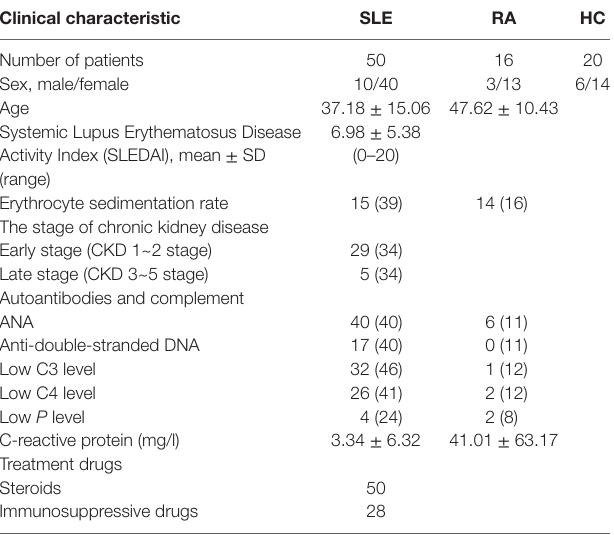
TaBle 1 | Clinical details of the patients with systemic lupus erythematosus (SLE), rheumatoid arthritis (RA), and healthy controls (HCs).